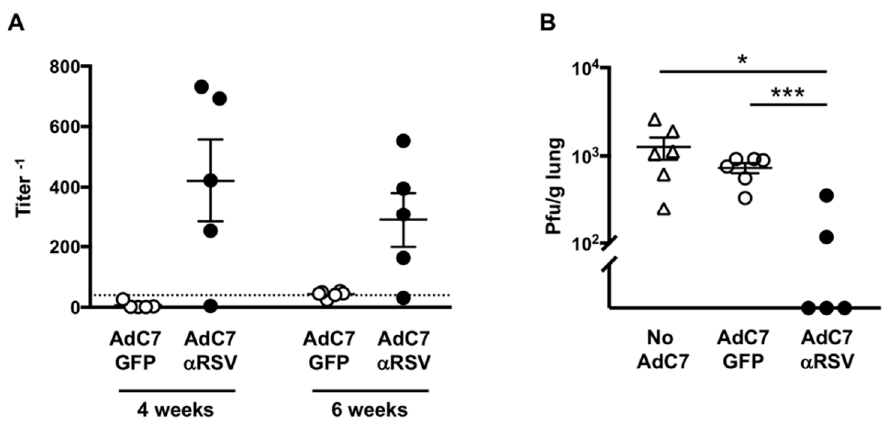
Figure 6. Protection against RSV infection following AdC7 α RSV administration to neonatal mice. AdC7 α RSV or AdC7GFP (6 × 10 10 pu) were intranasally administered to 1-day-old BALB/c mice, followed by RSV A2 (10 6 pfu) challenge at 6 weeks of age. ( A ) Anti-RSV IgG titer in serum before the RSV challenge. Serum was collected at 4 and 6 weeks, and titers were measured by ELISA. Data are shown with mean ± SEM. ( B ) RSV viral loads in the lungs 4 days after the RSV challenge by plaque assay. Data are shown with mean ± SEM. * and *** denote p < 0.05 and p < 0.005, respectively.